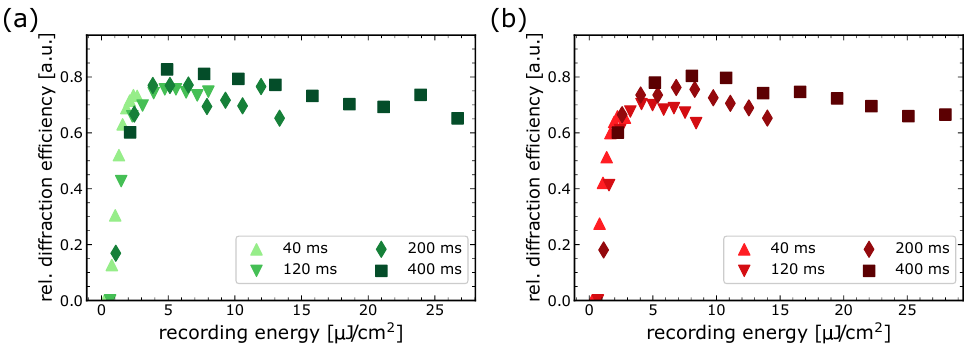
Figure 5. Relative diffraction efficiencies obtained for holograms recorded in the green ( a ) and red ( b ) spectral function.